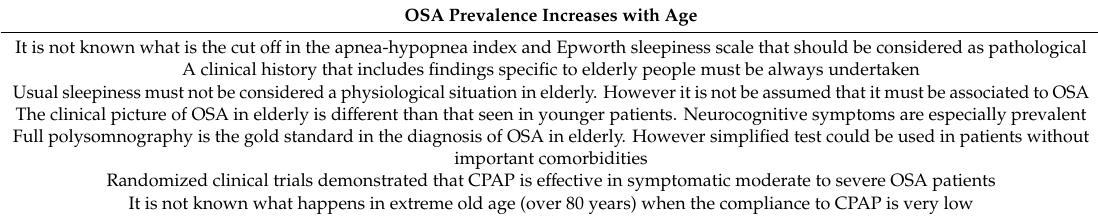
Table 4. Some messages about obstructive sleep apnoea (OSA) and CPAP treatment in the elderly. OSA Prevalence Increases with